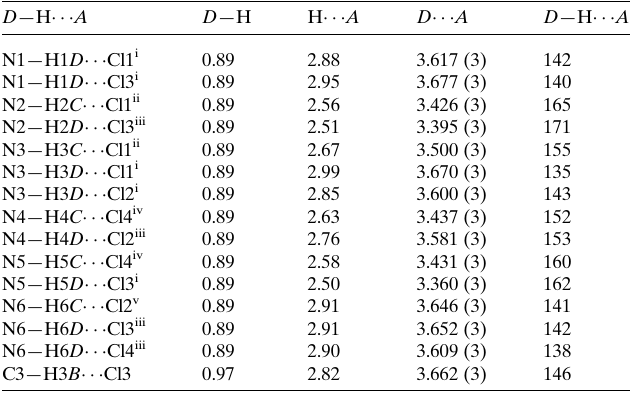
Table 1 Hydrogen-bond geometry (A˚ , (cid:5) ).